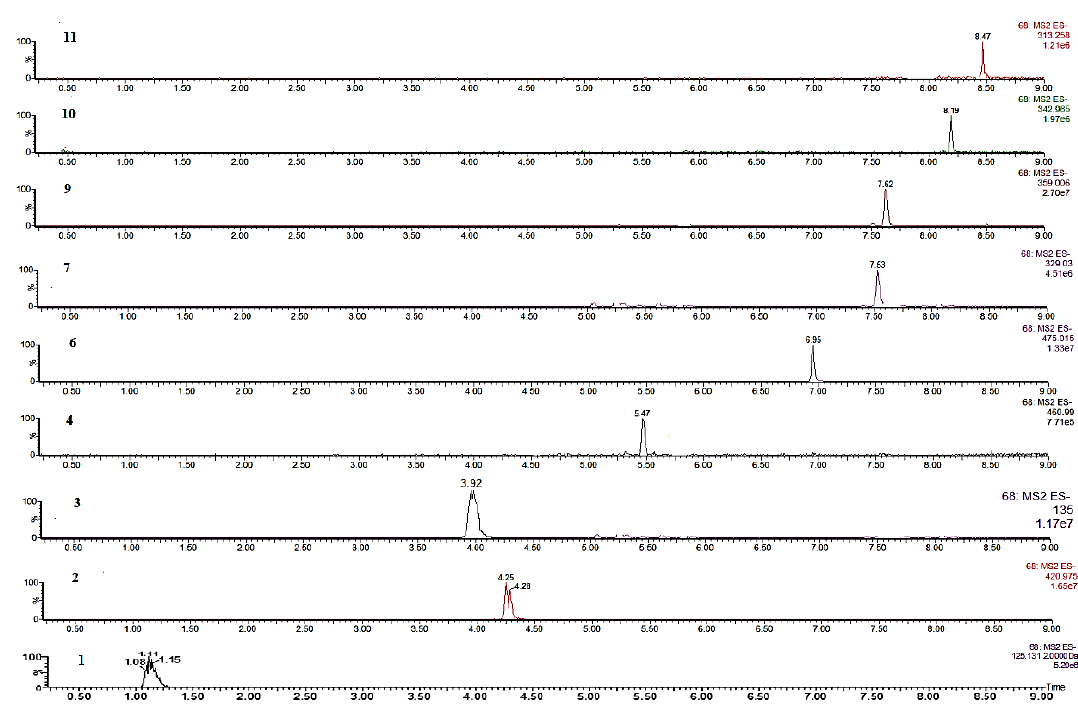
Figure 3. UPLC-MS chromatograms of compounds in the negative ion mode: Gallic acid ( 1 ) (1.14 min), mangiferin ( 2 ) (4.21 min), caffeic acid ( 3 ) (3.92 min), tectoridin ( 4 ) (5.47 min), irisolidone D -glucoside ( 6 ) (6.95 min), iristectorigenin B ( 7 ) (7.53 min), irigenin ( 9 ) (7.62 min), 5,6-dihydroxy-7,8,3′,5′-tetramethoxyisoflavone ( 10 ) (8.19 min), and irisolidone ( 11 ) (8.47 min).